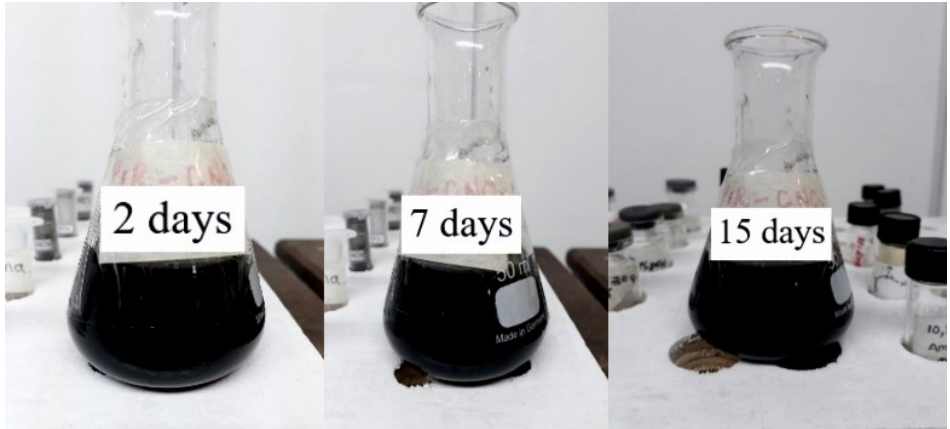
Figure 2. Dispersions of CNOs that were functionalized with the pyrene ( pyr -CNOs) in water. The Fourier transform infrared spectra (FT-IR) showed the presence of carboxylic and pyrene groups on the functionalized CNOs (Figure 3). Based on IR spectroscopy, a broad absorption band that extended from 2800 to 3200 cm − 1 indicated the presence of carboxylic groups (stretching